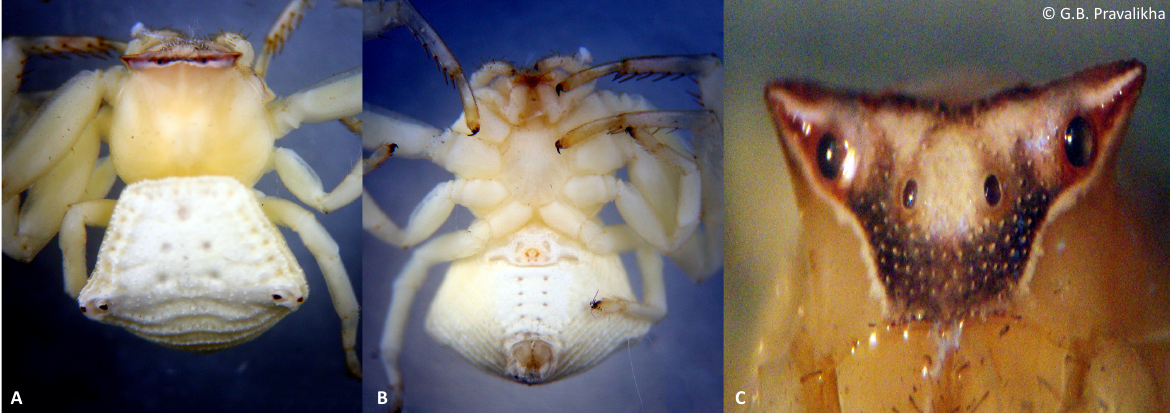
Legs: Leg I, II long and stout leg, III smallest.Spines